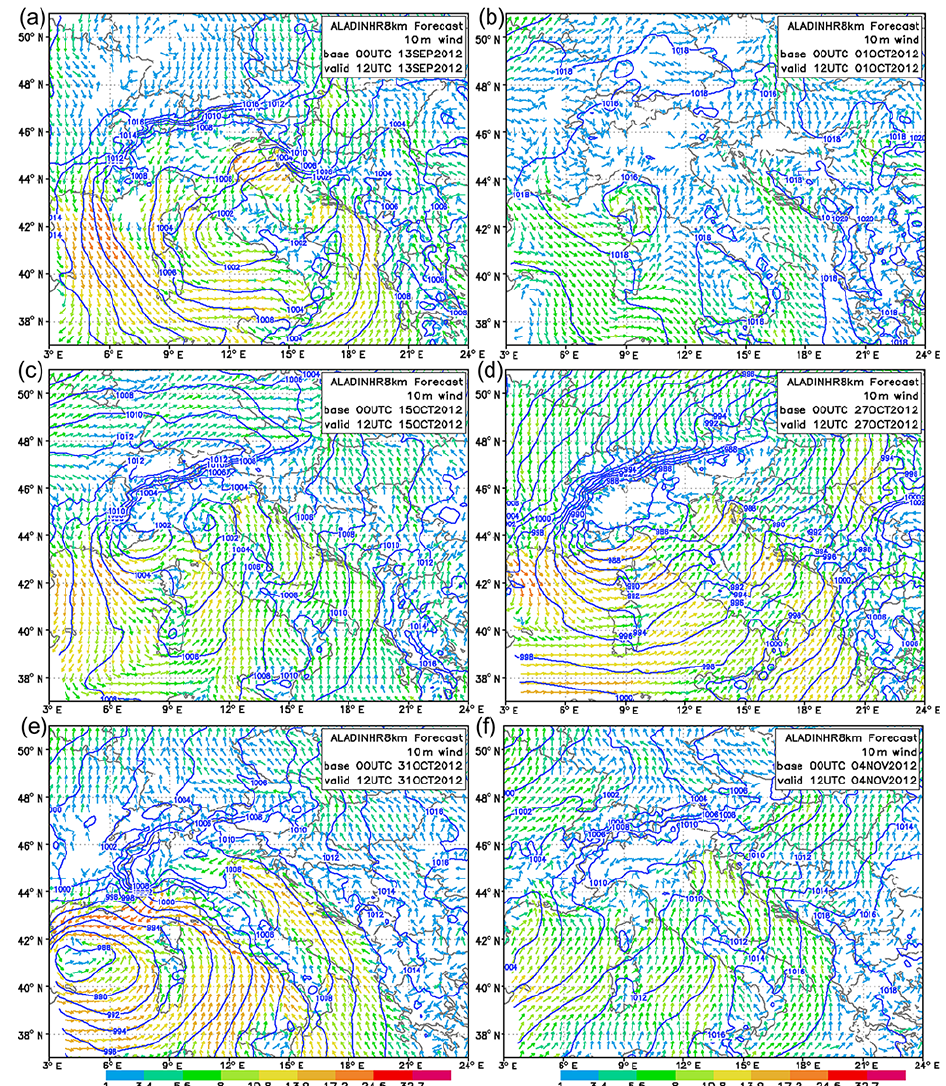
Figure 3. Horizontal wind at 10m (arrows coloured according to wind speed) and mean sea level pressure (blue isolines) forecasts by the ALADIN 8km-resolution run for 12:00UTC for (a) IOP4 (13 September), (b) IOP9 (1 October), (c) IOP13 (15 October), (d) IOP16 (27 October), (e) IOP18 (31 October), (f) IOP19 (4